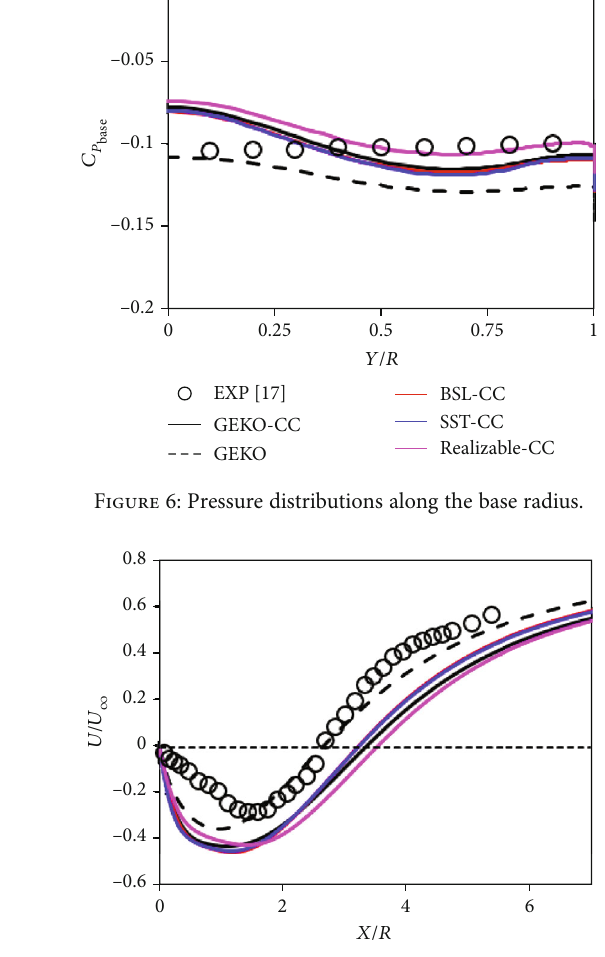
Figure 7: Velocity pro fi les along the centerline of the